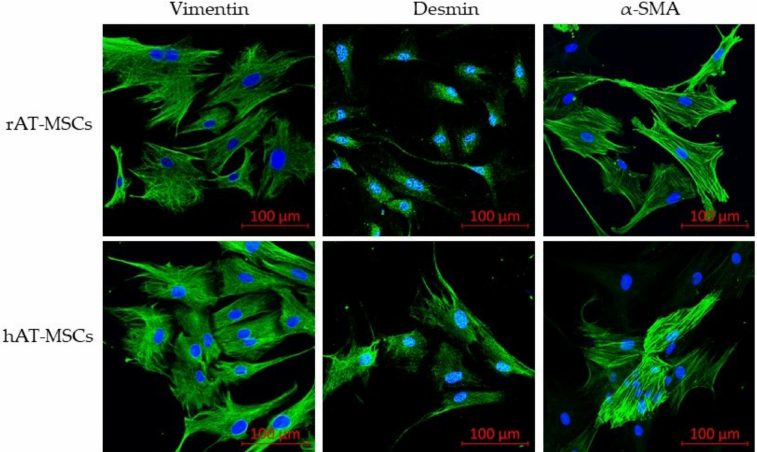
Figure 2. Immunofluorescence of selected surface markers of rabbit (rAT-MSCs) and human (hAT-MSCs) samples (scale bar = 100 µ m).